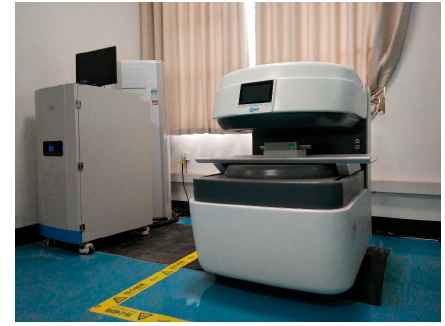
Figure 2. The MacroMR12-150H-I instrument.